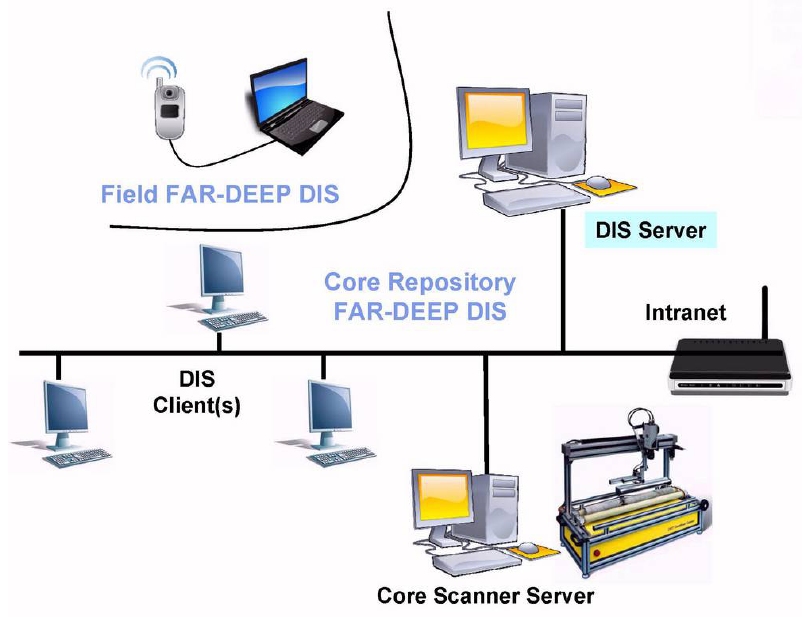
Figure 1: Typical setting of a DIS local area network in the field and a laboratory - see also: http://www.icdp-online.org/support/service/data-sample-management/technical-requirements/.